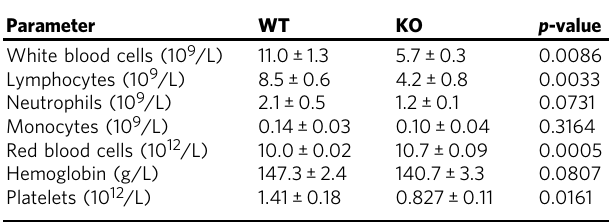
Table 1 Complete blood counts of peripheral blood in